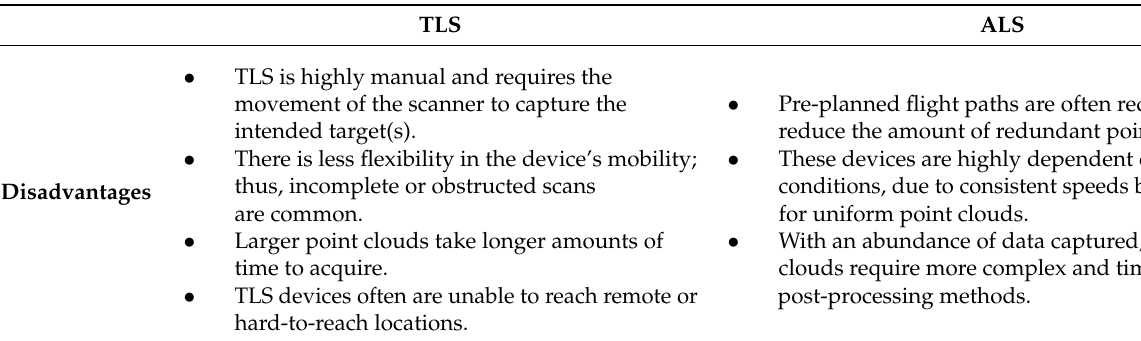
Table 1. Cont. TLS ALS